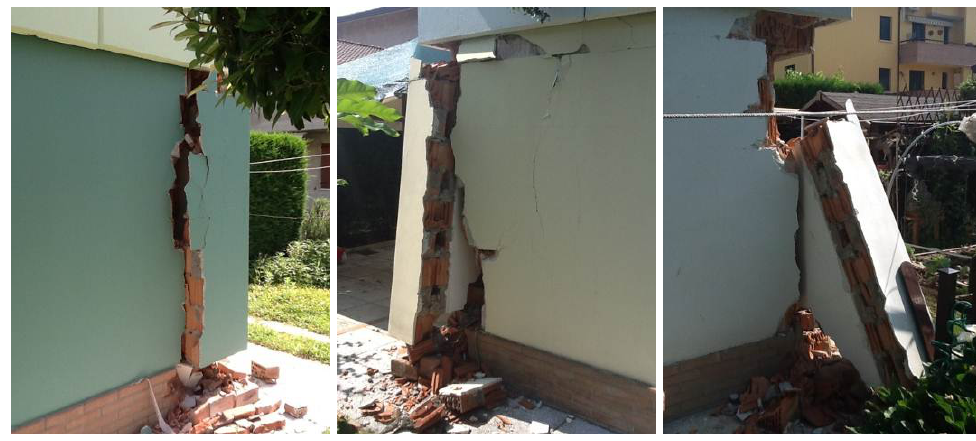
Figure 20. Corner failure of hollow brick masonry